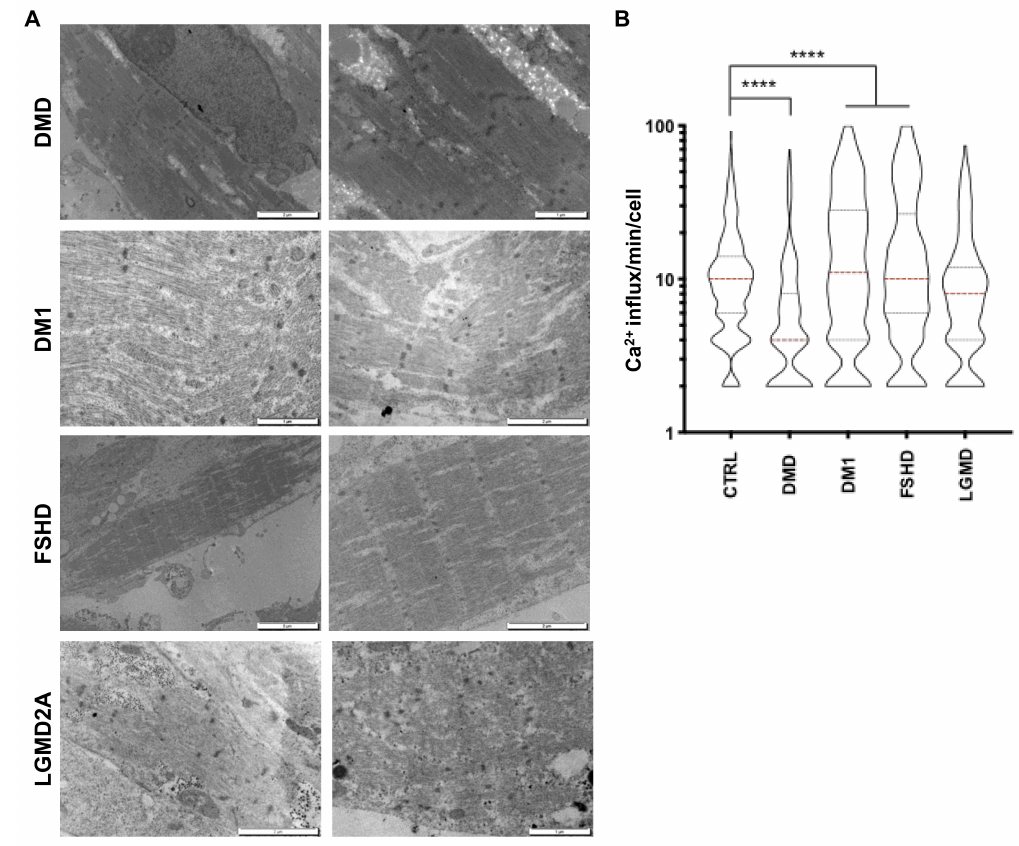
Figure 6. Functional and ultrastructural characterization of diseased hiPSC-derived muscle fibers. ( A ) Ultrastructural features of hiPSC-derived muscle fibers for di ff erent neuromuscular disorders. Electron microscopy was performed 60 days postdi ff erentiation. Representative images for DMD, DM1, FSHD and LGMD2A are presented. ( B ) Intracellular calcium signaling in hiPSC-derived